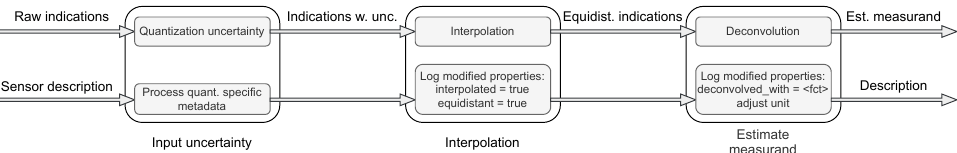
Figure 3. Chain of agents to estimate a measurand using a dynamic calibration model. A generic template for the agents is depicted above the agent chain.